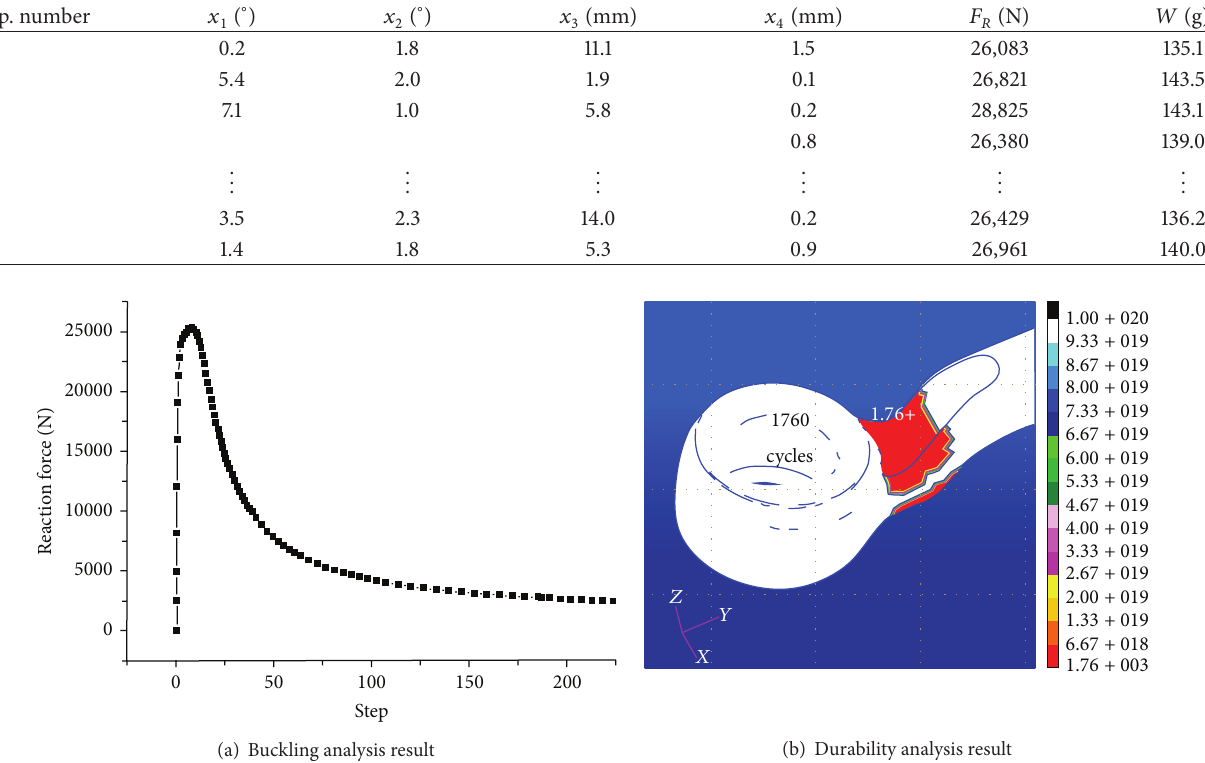
(b) Durability analysis result